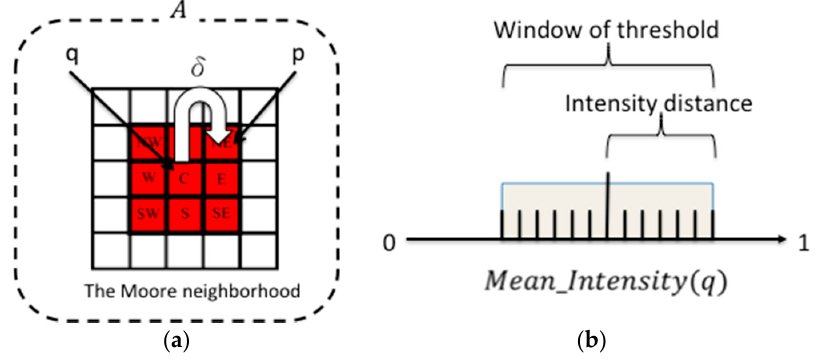
Figure 2. ( a ) Region-growing process from q to 8-connected neighbors p that satisfy the δ function; and ( b ) threshold for the window of intensity. The center of the window is the value of Mean_Intensity, and the window size is +/ − the intensity distance (+/ − 0.065).